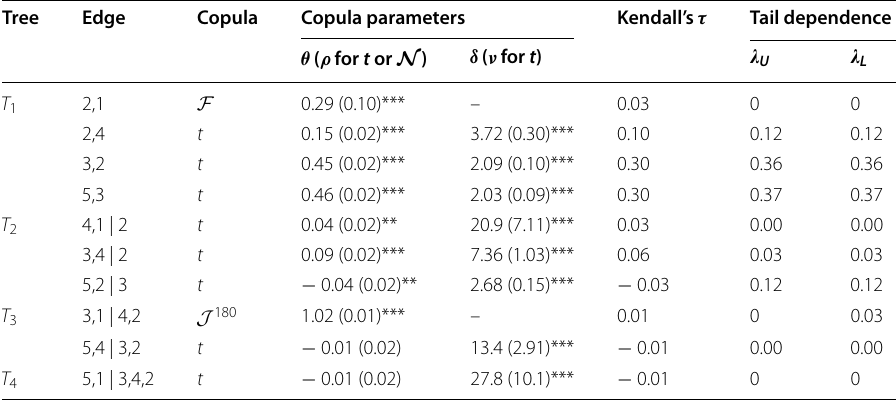
Table 9 Full estimation results of the R-vine copula for G7 basket